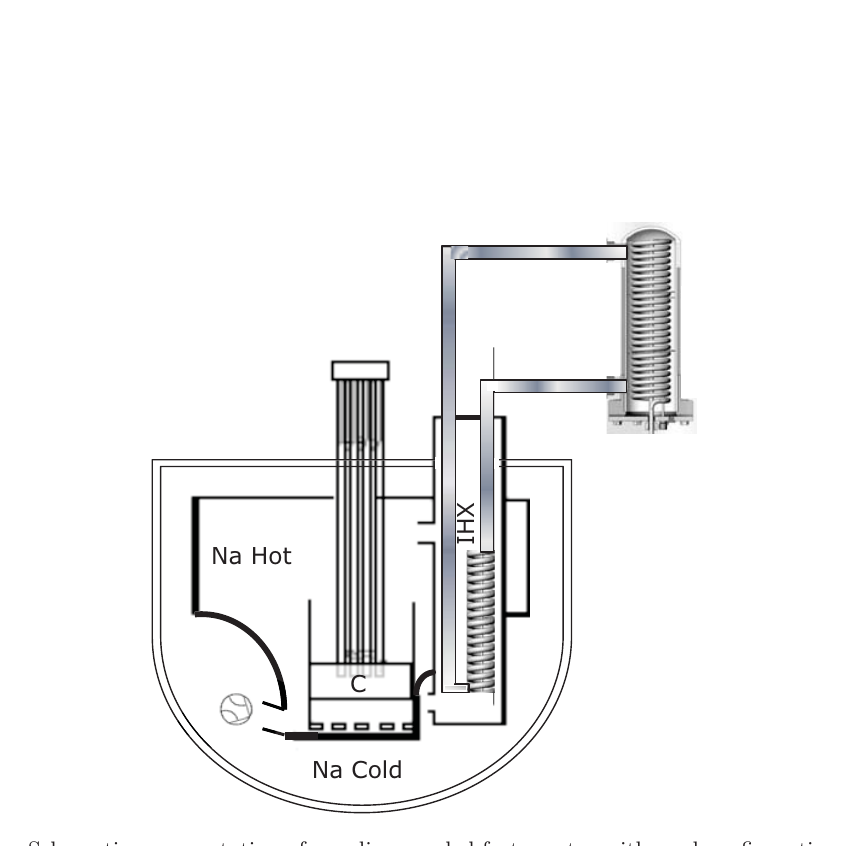
Fig. 3. – Schematic representation of a sodium-cooled fast reactor with pool configuration. C is the core, IHX is the intermediate heat